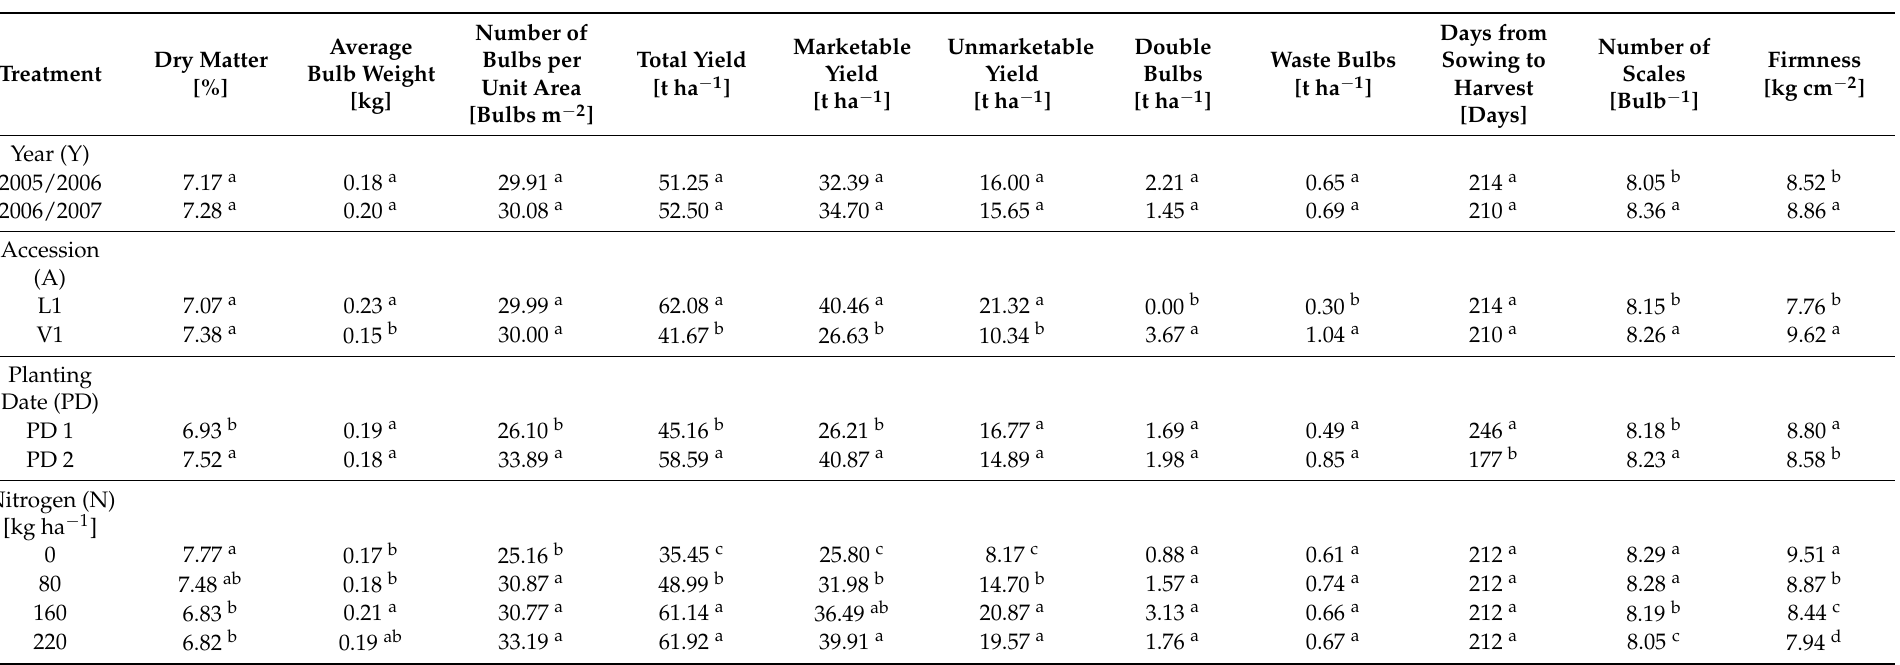
Table 1. Production parameters for onions in response to year (Y), accession (A), planting date (PD), and nitrogen dose (N).